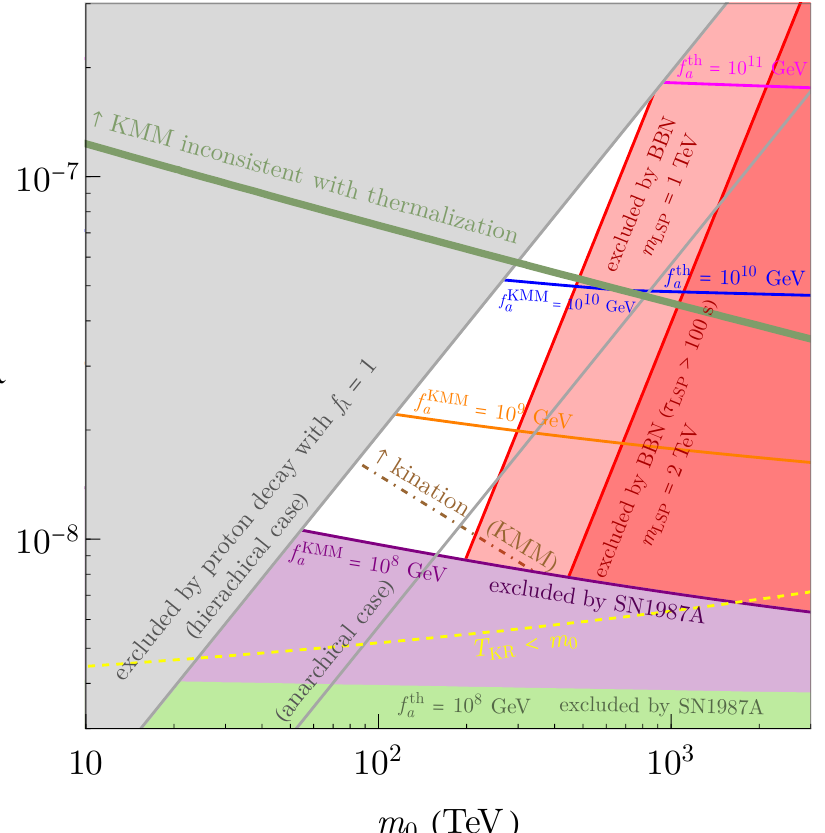
Figure 2 . Parameter space of RPV axiogenesis in the scalar mass m 0 and the dimensionless RPV coupling λ . Light (dark) red shaded region: late decays of the LSP spoil BBN for m LSP = 1 (2) TeV (section 3.2). Gray region (line): too rapid proton decay from RPV in the case of hierarchical (anar- chical) flavor structure (section 3.1). Solid colored contours: upper bounds on the decay constant f